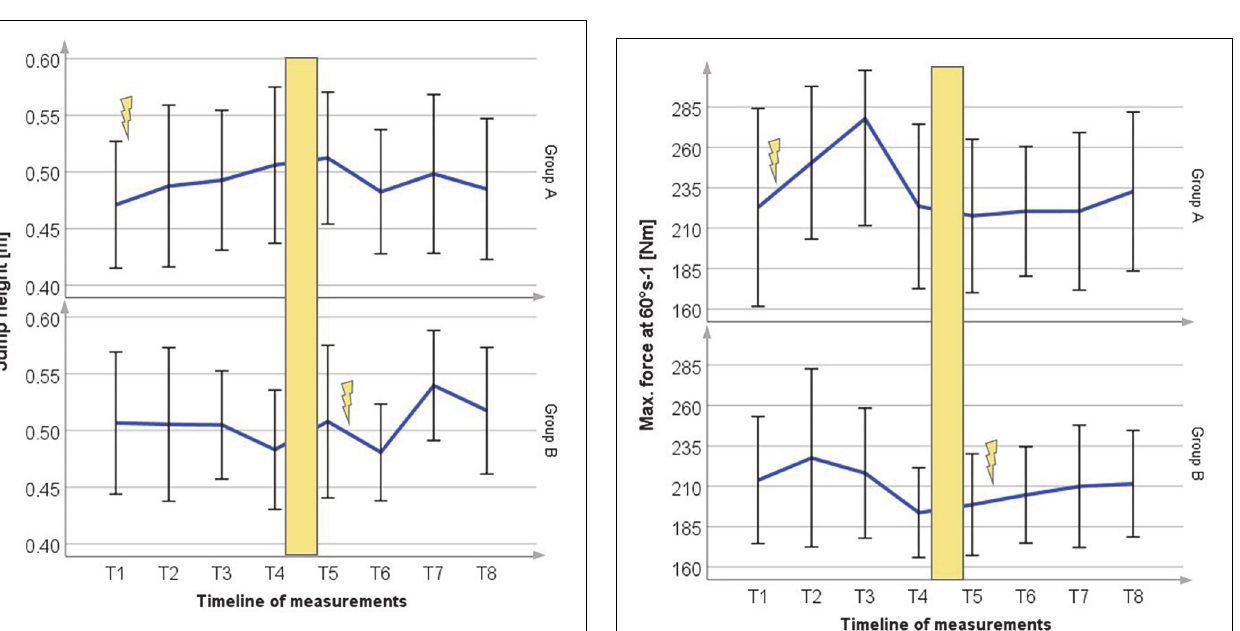
FIGURE 5 | Mean ( ± SD) change in maximum voluntary force at 60 ◦ /s for Group A period 1 and Group B period 2. Lightning bolt represents each respective WB-EMS period; yellow area = wash-out